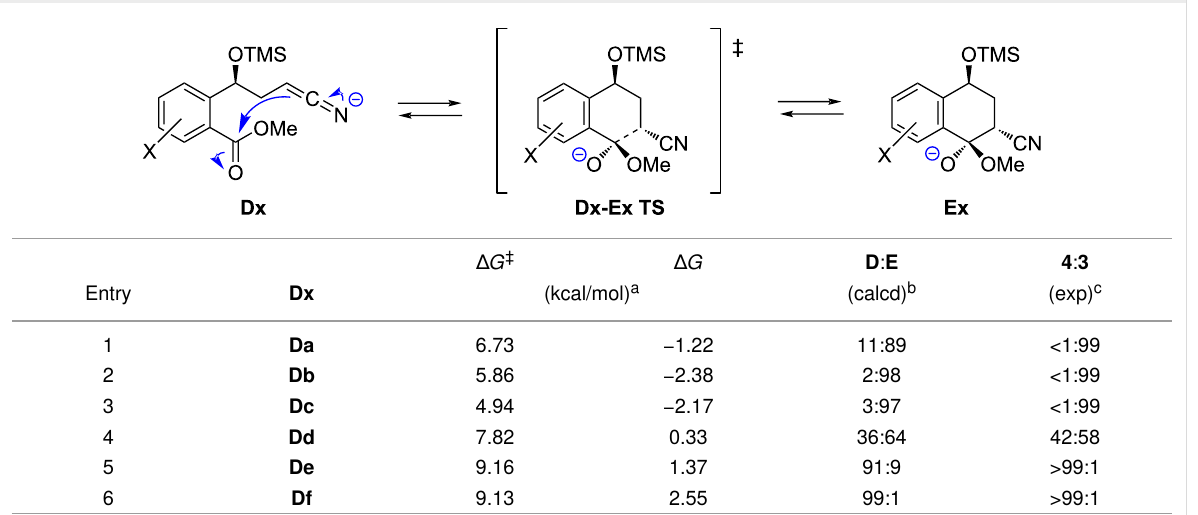
Table 4: Calculations of activation energies ( ∆ G ‡ ) and energy differences ( ∆ G ) from Dx to Ex .